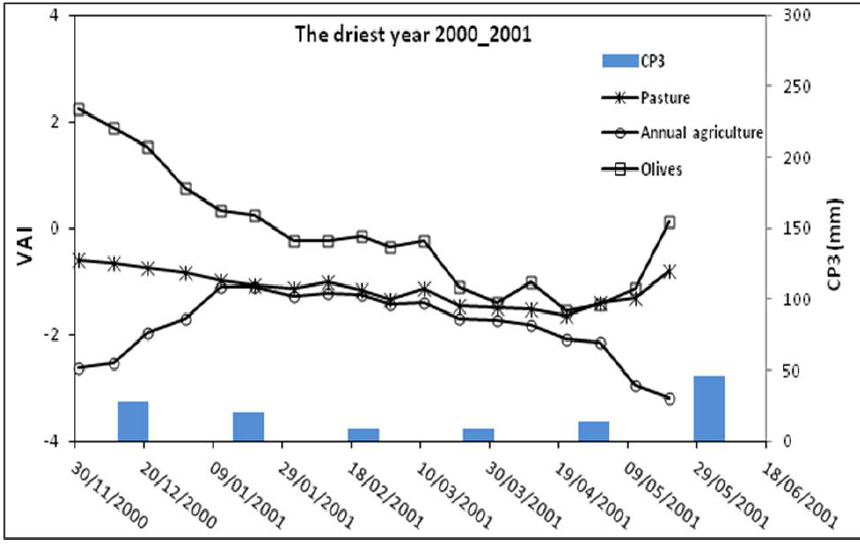
Figure 10. Variations in the monthly VAI for each type of vegetation cover, with data points at 10-day (decade) intervals from December to the end of May, for two different periods: (a) the drought year 2000–2001, (b) the wet year